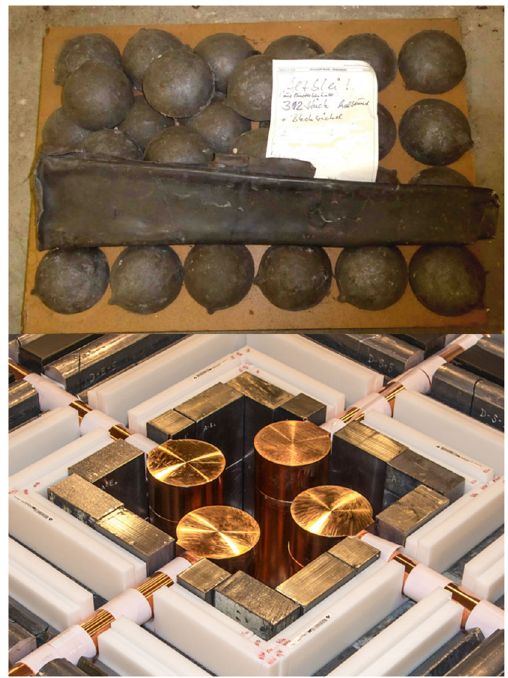
Fig. 15 Top: Old Pb half-spheres from the Freiburg Minster, low in 210 Pb activity. Bottom: Innermost Pb layer of the CONUS shield con- sisting among others of the Pb bricks melted from the Freiburg Minster Pb